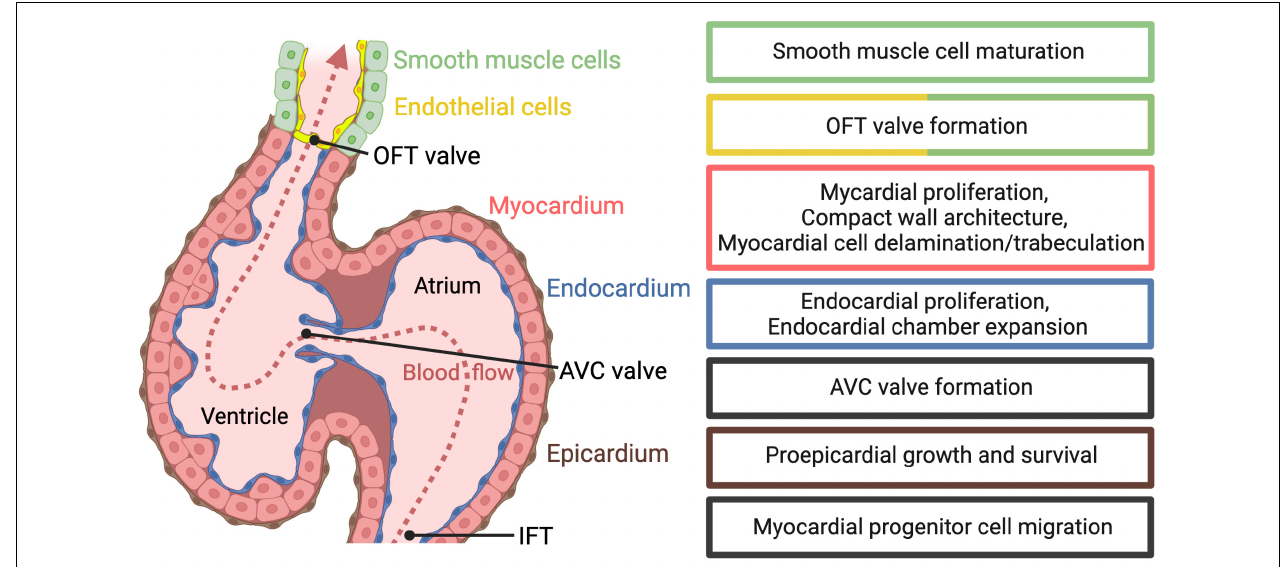
FIGURE 2 | Hippo pathway-dependent developmental processes during early cardiac development in zebrafish. The zebrafish heart tube at 5 days post fertilization consists of the inner endocardium (blue), myocardium (red), and the surrounding epicardium (brown). The atrioventricular (AV) valve, comprised of myocardial and endocardial cells, and the outflow tract (OFT) valve, comprised of smooth muscle and endothelial cells, have formed and blood flow has a unidirectional flow pattern (dashed red line). The ventricular myocardium has segregated into inner trabecular and outer compact wall layers. Hippo pathways-dependent processes discussed in this review are highlighted in the colored